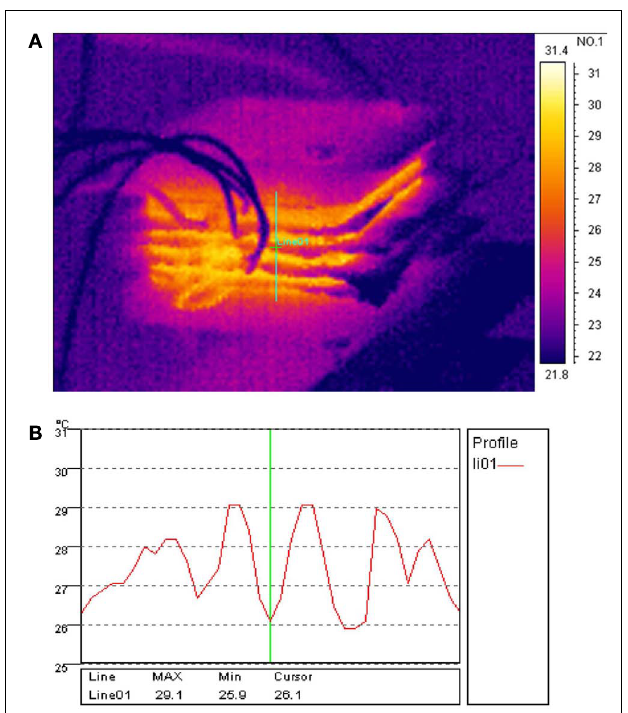
FIGURE 13 | Fuel cell stack temperature distribution at operation current of 3A . (A) Thermal image of fuel cell stack and (B) five graphite plate temperature